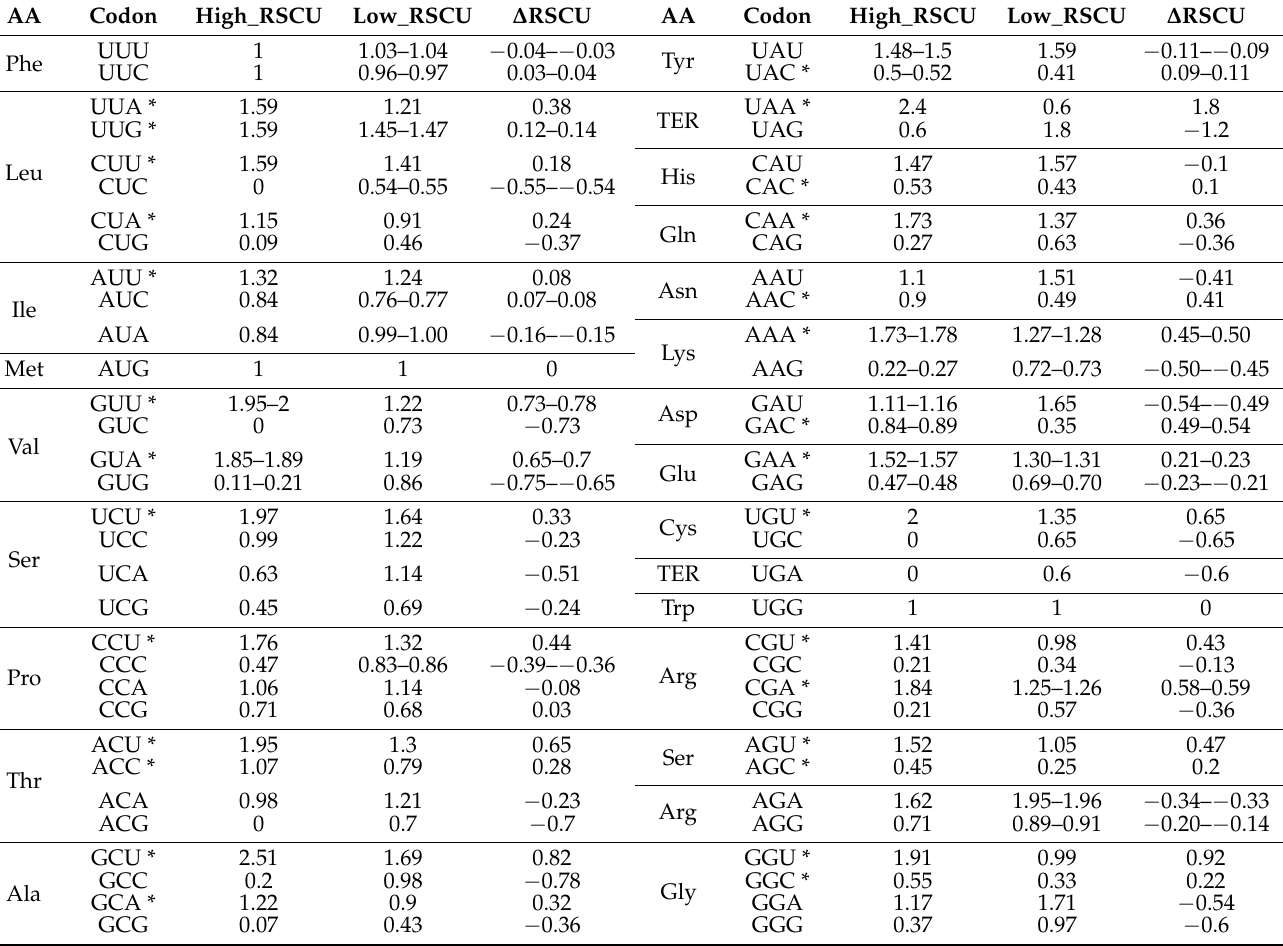
Table 6. Preponderant codon analysis of the chloroplast genome of oil-tea